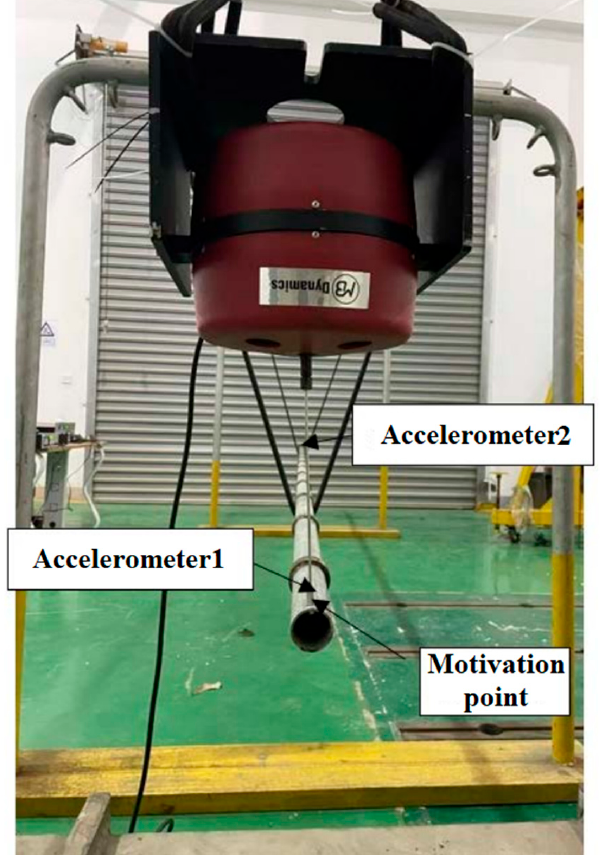
Figure 2. Vibration damping performance test platform with local oscillator cycle pipe. Table 2. The physical parameters of the periodic pipeline material.